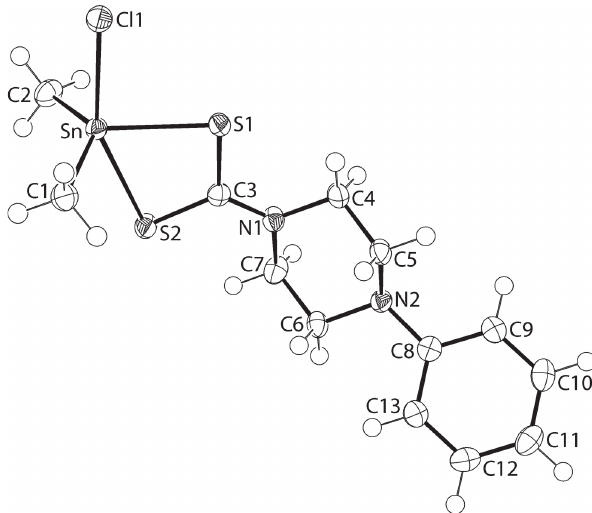
Table 1: Data collection and